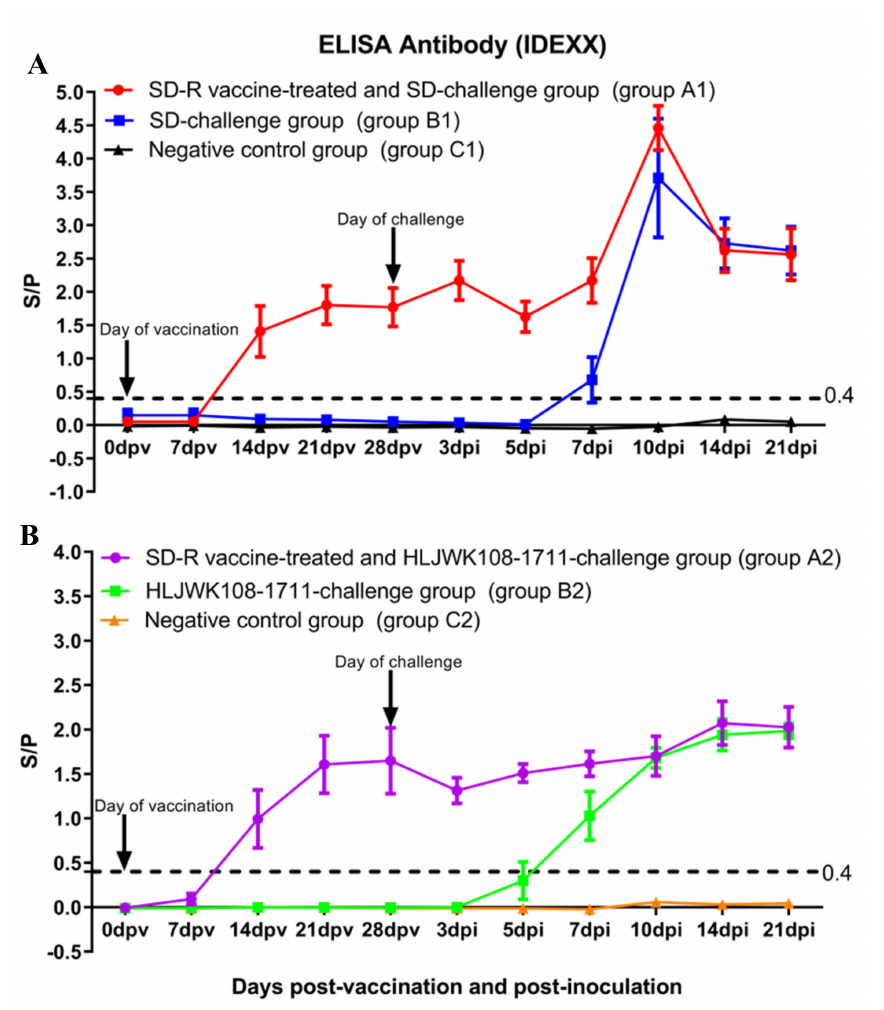
Figure 5. Anti − PRRSV antibody levels after SD − R immunization and challenge with parental virus SD ( A ) and NADC30 − like PRRSV HLJWK108 − 1711 ( B ). Solid line, threshold value above ≥ 0.4, in which titers were considered positive for anti − PRRSV antibodies. The groups A1, B1, and C1 are labelled with red, blue, and black, respectively. The groups A2, B2, and C2 are labelled with purple, green, and orange,